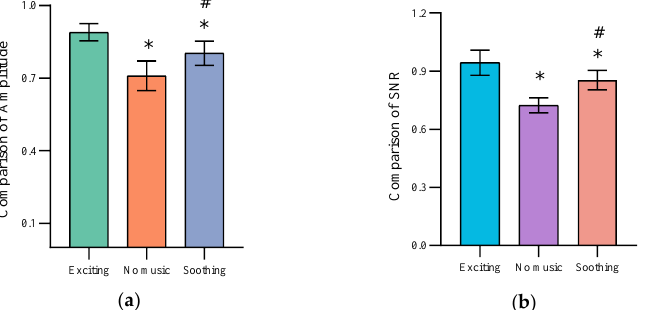
Figure 5. Comparison of the variation of SSVEP amplitude and SNR under different background music modes. ( a ) Comparison of Amplitude. ( b ) Comparison of SNR. *: Significant difference from exciting Music mode. #: Significant difference from no Music mode.